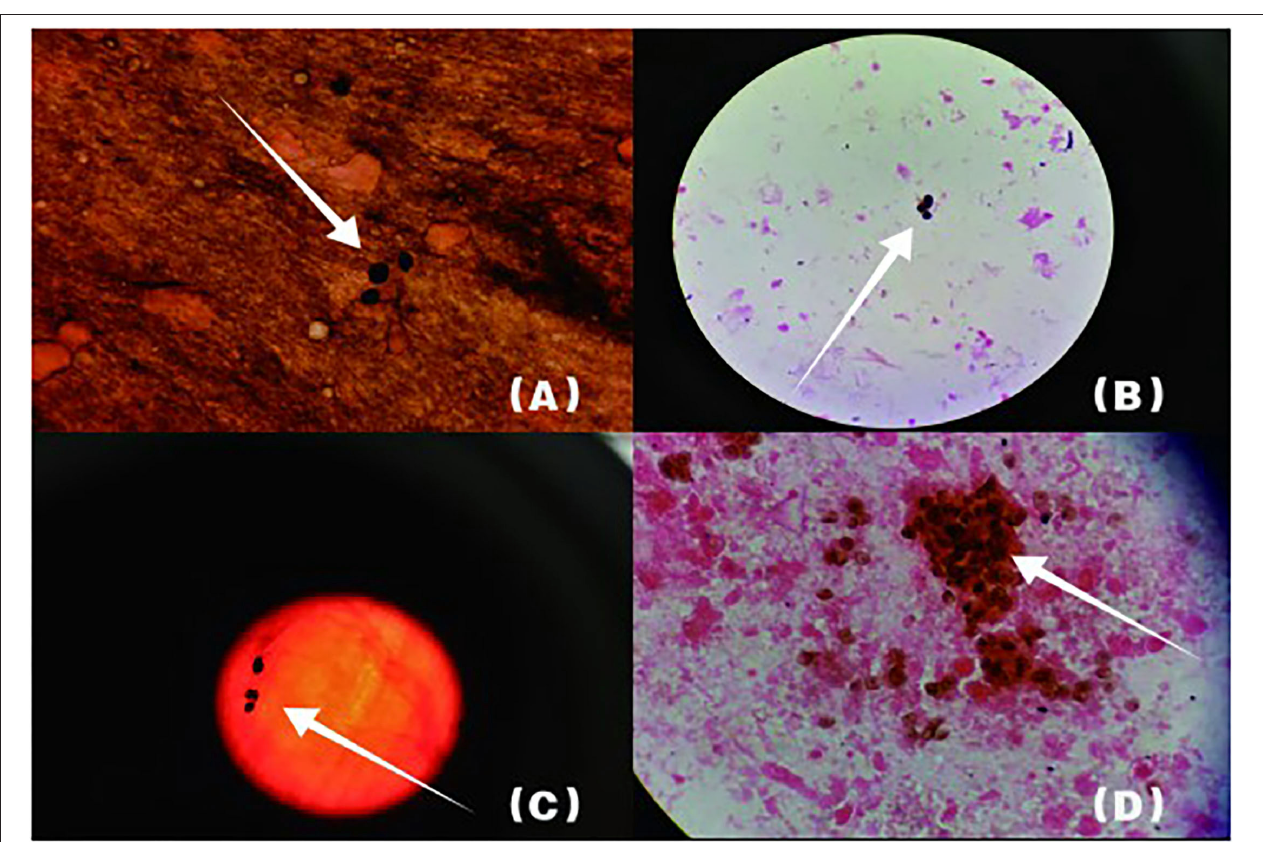
FIGURE 2 | Arrowheads show P. jirovecii cysts which are round or oral. The cyst wall is darkened or brownish-black by GMS, while the content is almost colorless. (B) shows lung tissue specimen, (A,C,D) are BALF specimens.